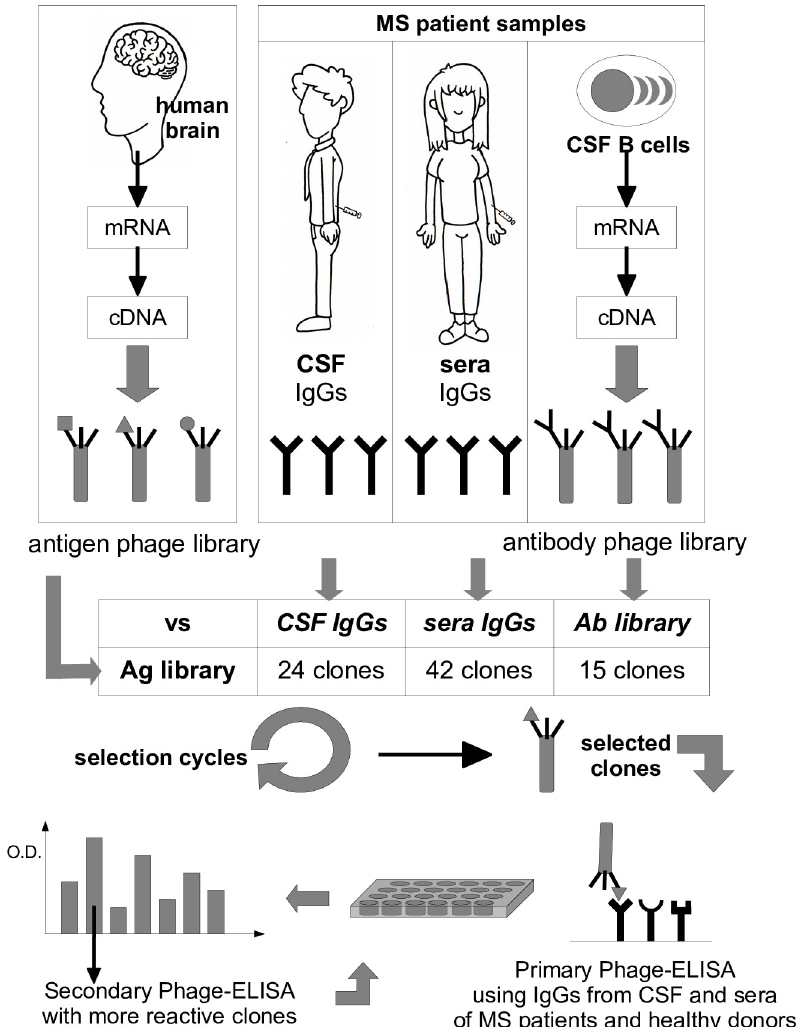
Fig 1. Overview of the biopanning. Schematic overview of the phage display selection approach for the identification of candidate autoantigens in multiple sclerosis.